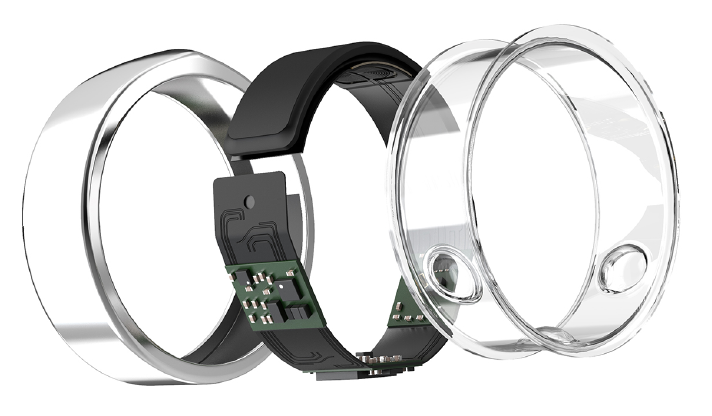
Figure 1. Technical illustration of the second generation Oura ring. The ring has a titanium cover, bat- tery, power handling circuit, double core processor, memory, two LEDs, a photosensor, temperature sensors, 3-D accelerometer, and Bluetooth connectivity to a smartphone